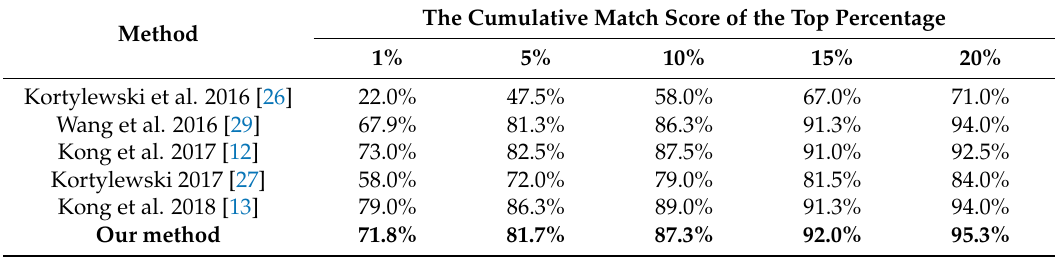
Table 5. Comparisons with the state-of-the-art shoeprint retrieval algorithms on the FID-300 dataset.